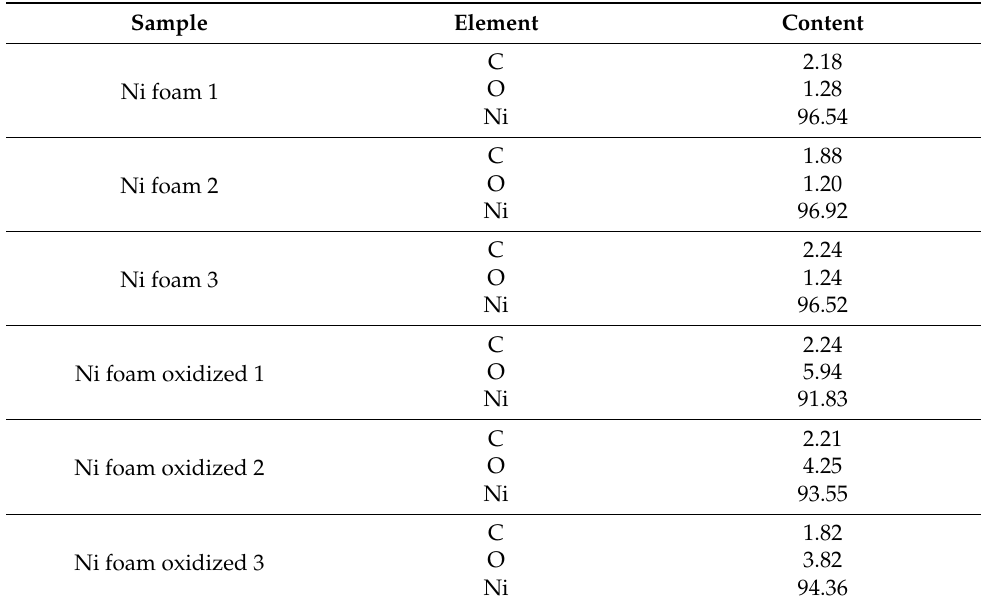
Table 2. Elemental content (wt.%), derived for three unmodified nickel foam electrodes and electro- oxidised Ni foam anodes by means of EDX